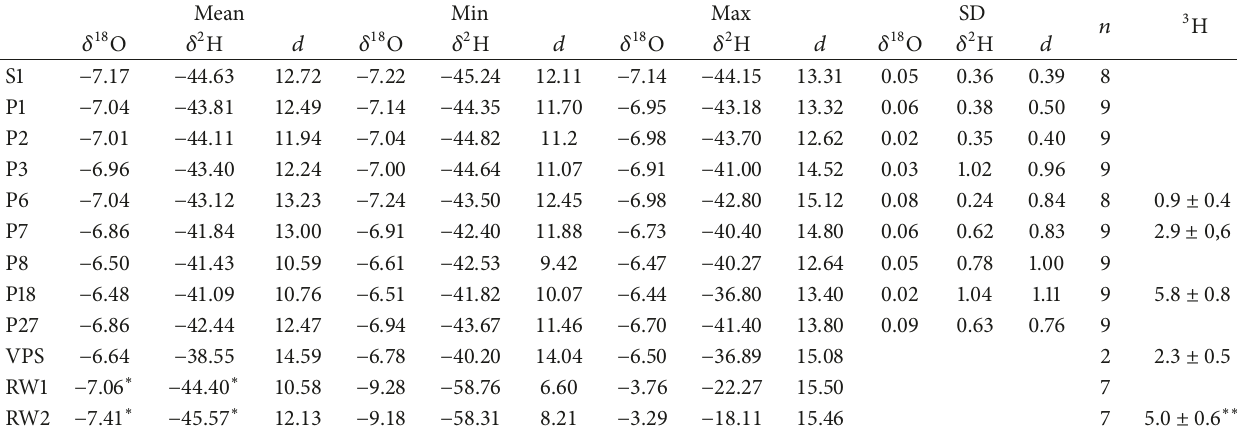
Table 2: Isotopic composition ( 𝛿 18 O, 𝛿 2 H, and 3 H) and deuterium excess ( 𝑑 ) of groundwater and rainwater samples. Sampling for tritium analyses was performed, 06/02/2018 ( ∗ is used for monthly weighted values and ∗∗ is used for the total amount of rainfall collected from 05/11/2007 to 08/01/2008).